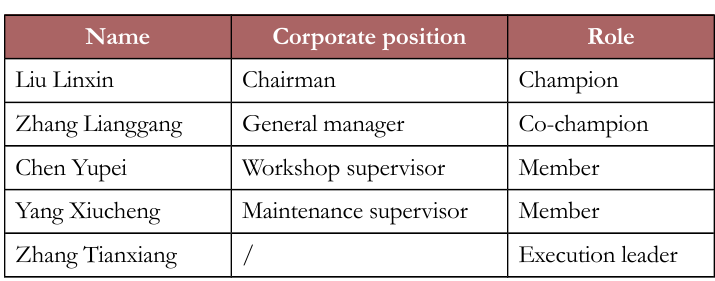
Table 1. The steering committee of BSL